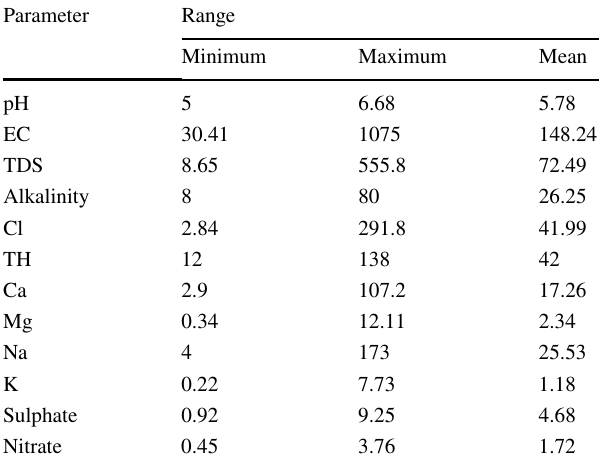
Table 3 Mean and range values of physicochemical parameters(All values are in ppm except pH and EC)EC is expressed in